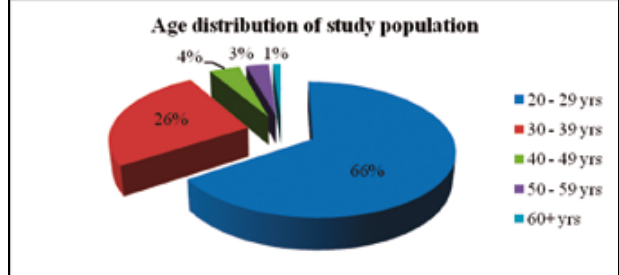
Fig. 3. Age distribution of the study